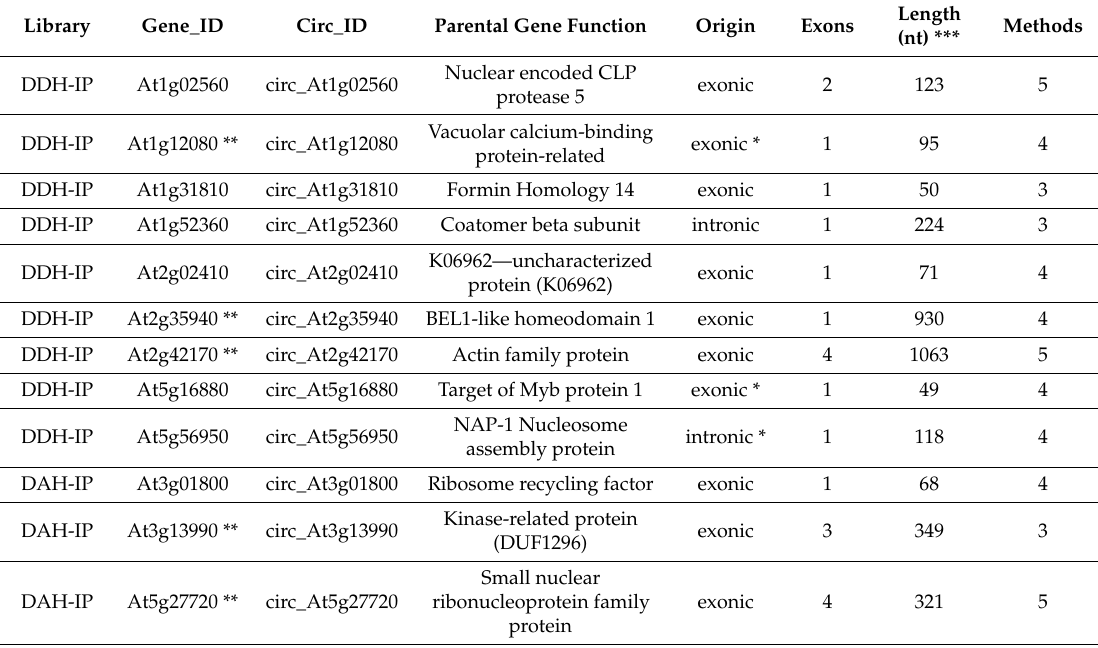
Table 2. Description of 12 putative circRNAs predicted by at least three methods.